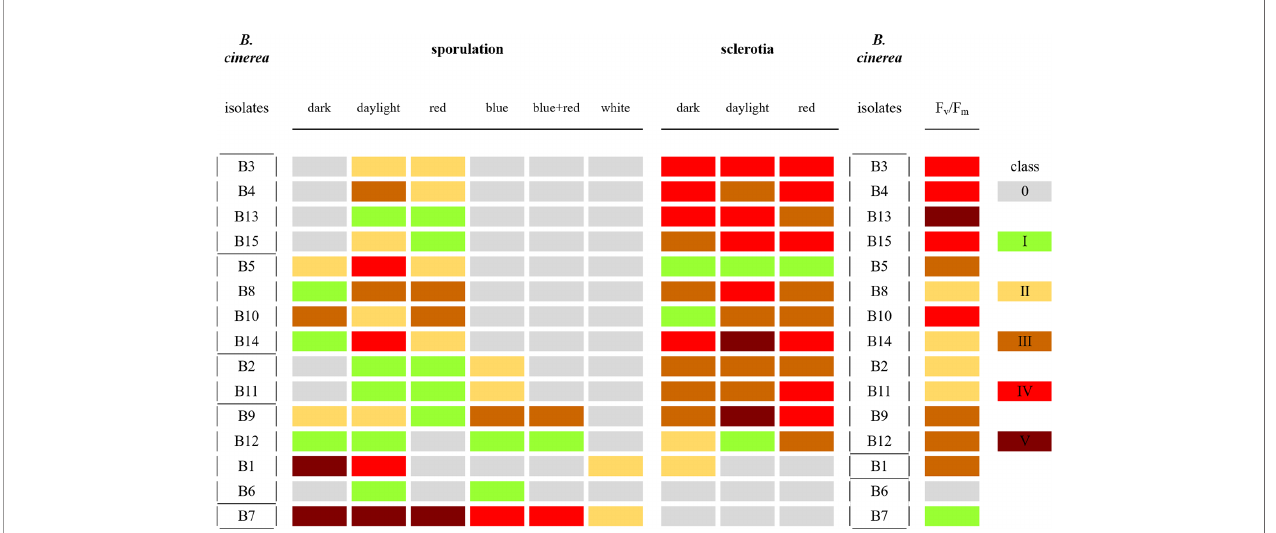
FIGURE 3 | Classi fi cation of sporulation and sclerotia formation in the 15 Botrytis cinerea isolates after 15 days under six light treatments: dark, daylight, white, blue, red, and blue+red LED, and classi fi cation based on F v /F m values at 4 dpi from infection in white-light-leaves. Classes of sporulation and sclerotia presented are from three replications with six plates for each replicate (n = 18). The classes of sporulation and sclerotia formation are: class 0 (no spores/sclerotia formation); class I (very few spores/sclerotia formation); class II (sporulation/sclerotia formation sparse); class III (average amount of spores/sclerotia formation); class IV (many spores/ sclerotia formation); class V (abundant spore/sclerotia formation). The class of virulence is based on the signi fi cant letters of F v /F m at 4 dpi ( Table 2 ) with exclusion of B6 which is indicated by a light gray color. The classes are: class I (signi fi cant letters starting with a); class II (signi fi cant letters starting with b); class III (signi fi cant letters starting with c); class IV (signi fi cant letters starting with d); class V (signi fi cant letters starting with e). These classes are shown in colors (see the color bar).